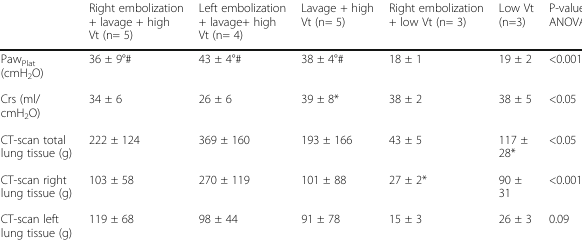
Table 16 (abstract A25). Severity of lung